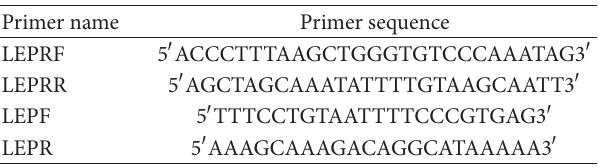
Table 1: Characteristics and sequences of primers for leptin and leptin receptor